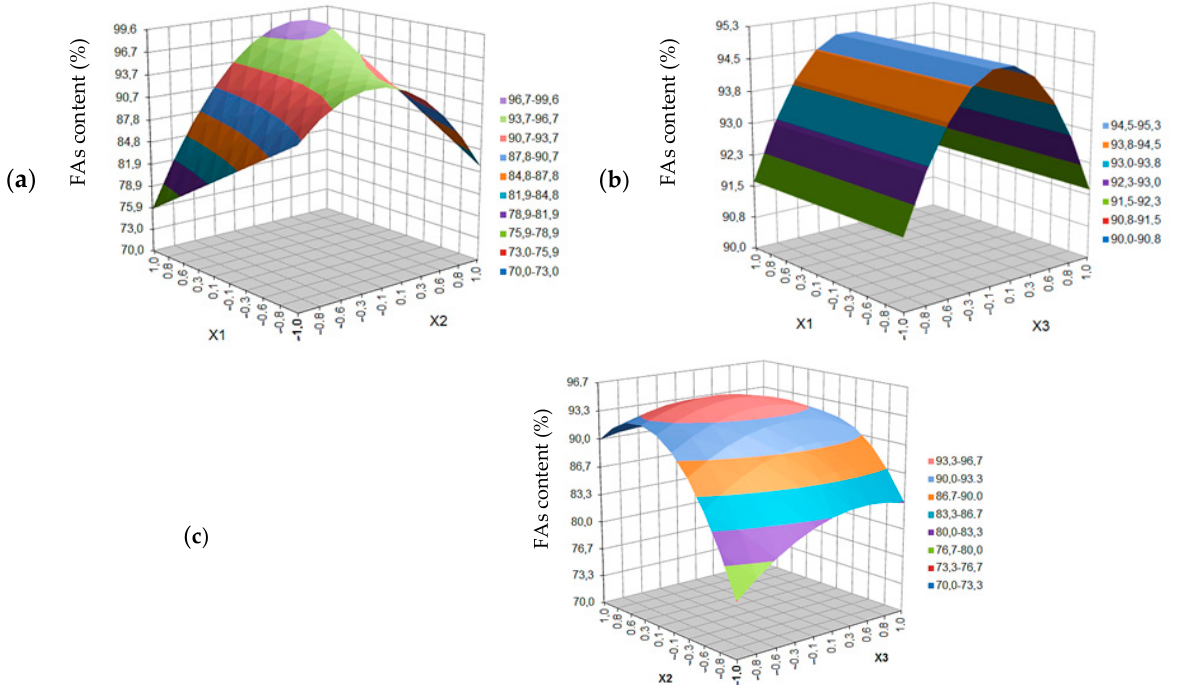
Figure 3. Response surface plot for fatty acid content in blackcurrant extract as a function of: ( a ) temperature ( X 1 ) and extraction pressure (X 2 ), ( b ) temperature ( X 1 ) and extraction time ( X 3 ), ( c ) pressure ( X 2 ) and extraction time ( X 3 ).